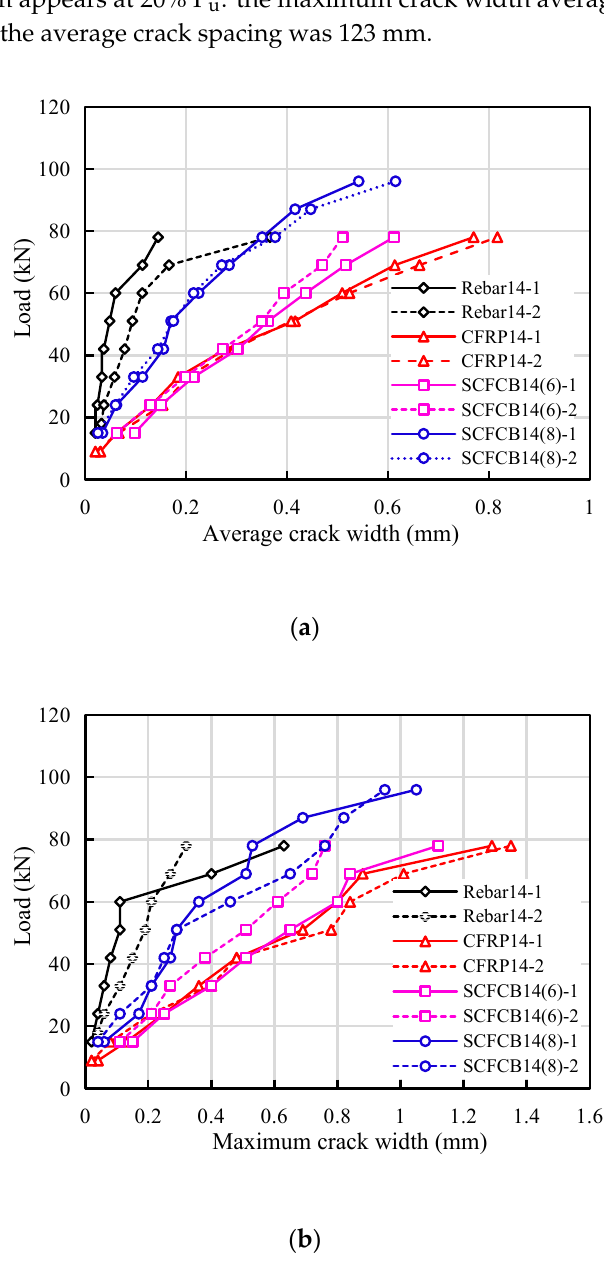
Figure 5. Crack width comparison from test results. ( a ) average crack width; ( b ) maximum crack width.